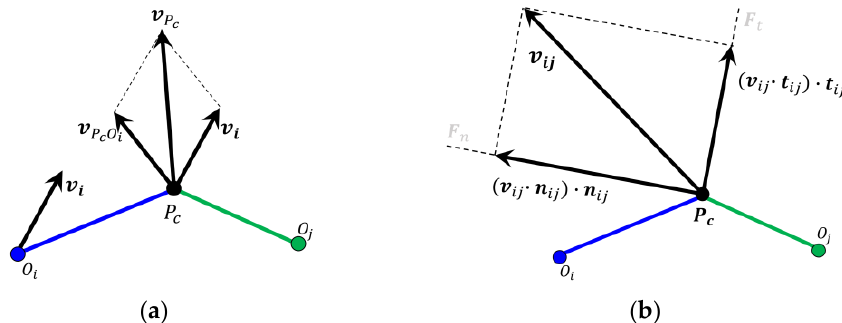
Centroid : Average of sample points Pass the action point and parallel with the line connecting two centroids of particles ( a ) ( b ) Figure 1. Contact model of non-circular particles: ( a ) Super-ellipse 𝑎 𝑏⁄ = 1.5 , 𝑚 = 1.5 ; ( b ) Regular triangle. Based on the features, we determine the normal elastic force. For disks or spheres, the overlap magnitude is defined as a distance 𝛿 𝑛,𝑖𝑗 = 𝑅 𝑖 + 𝑅 𝑗 − 𝑅 𝑖𝑗 . But for non-circu- lar/non-spherical particles, it is far more effective when using area or volume (in 3D) [55,57]. Hence, we define the overlap magnitude as a function of the overlap area 𝑆 𝑜 ,